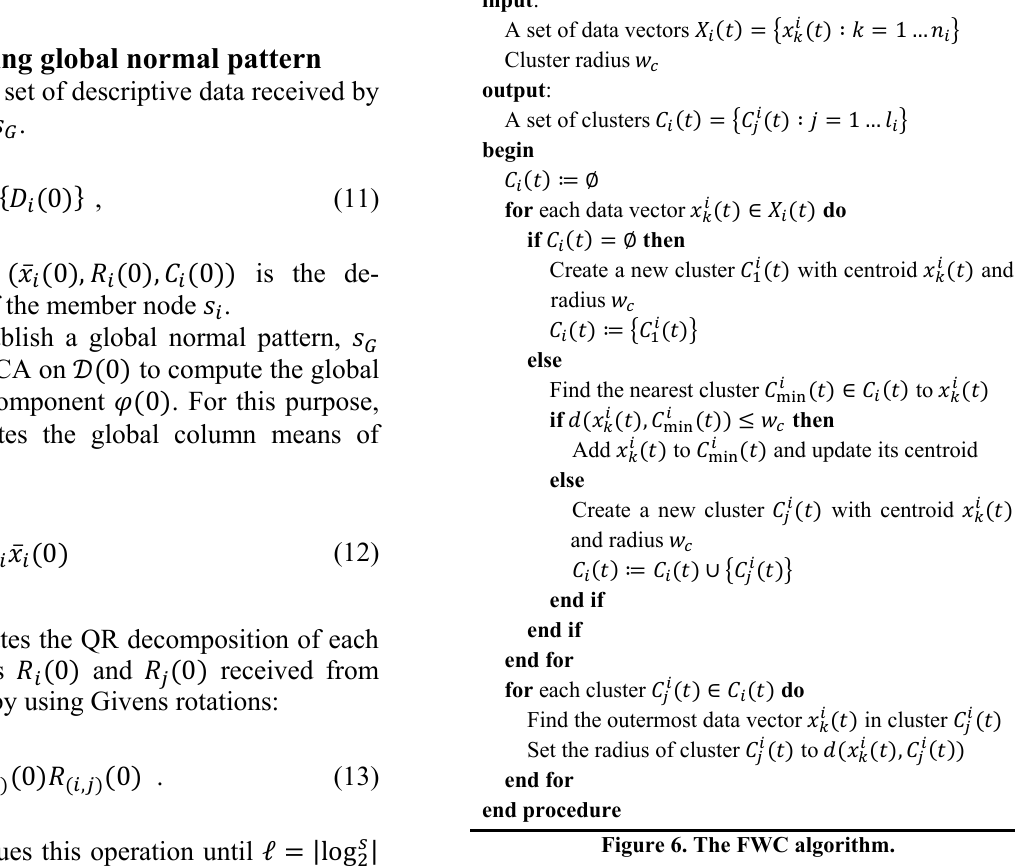
Figure 6. The FWC